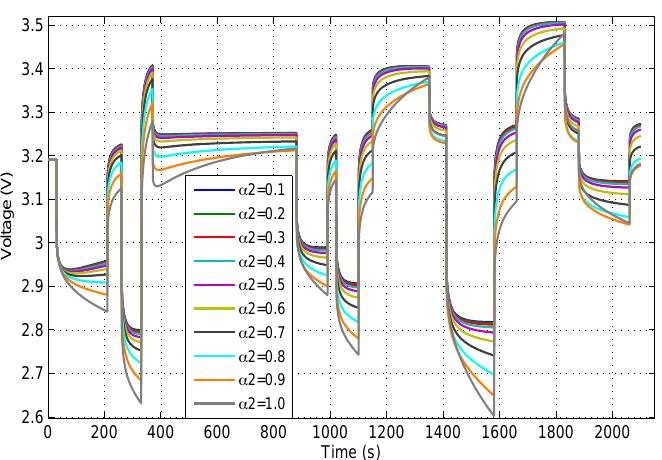
Figure 19. Differences of fractional-order model output voltage by changing value of α 2 .